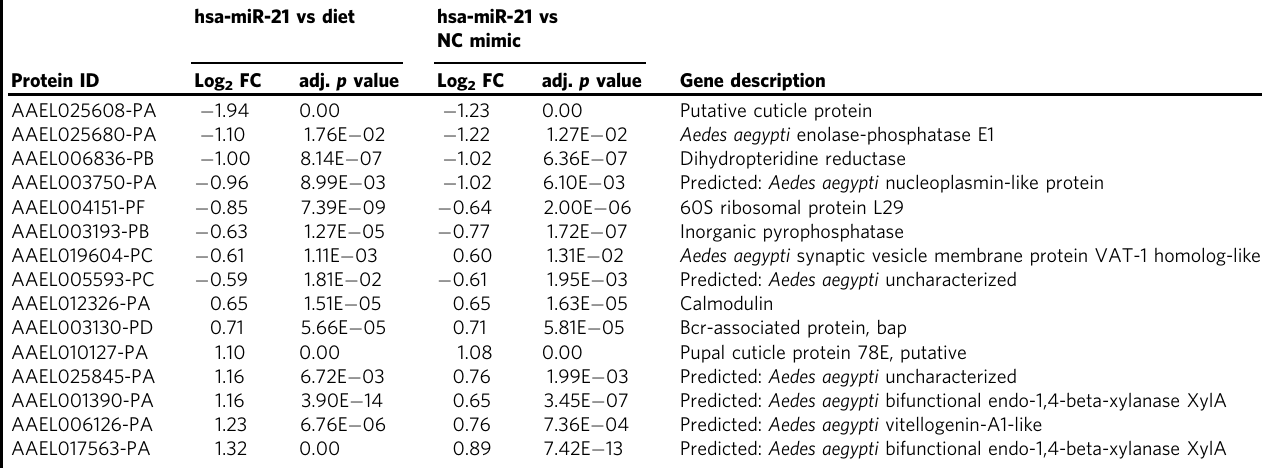
Table 1 Differentially abundant proteins in the fat body of Ae. aegypti after feeding on arti fi cial diet supplemented with hsa-miR- 21-5p